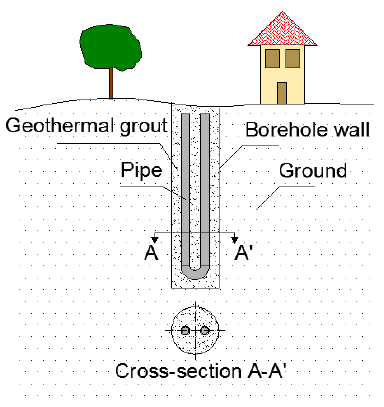
Figure 1. Main elements of a vertical closed-loop ground heat exchanger.